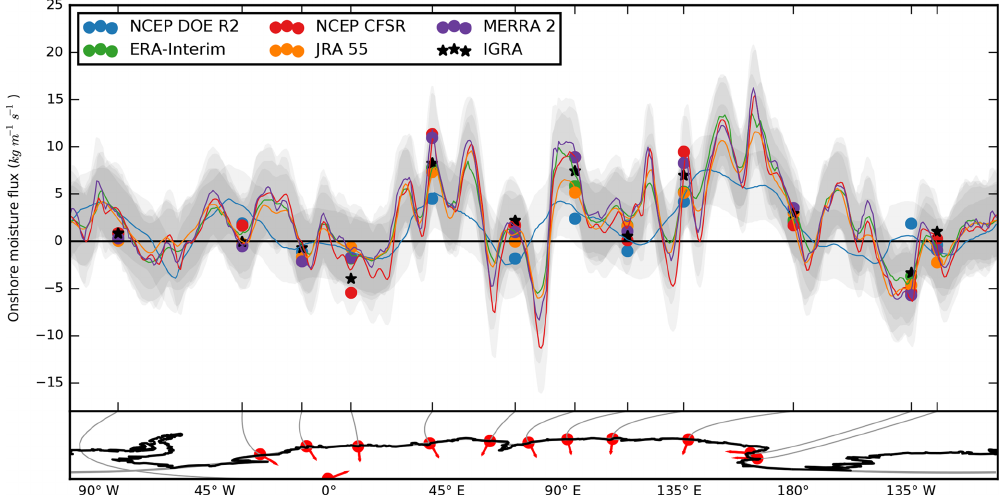
Figure 5. Distribution of the mean incoming vertically integrated moisture flux on the boundary of the Antarctic ice sheet in different reanalyses. The grey-shaded bands indicate the ranges corresponding to plus or minus 1 interannual standard deviation from the mean. Stars represent the radiosonde and dots the reanalyses interpolated over the launch sites, with the same temporal sampling as the observations. The red dots in the lower panel indicate the location of the sites and the arrows the direction normal to the